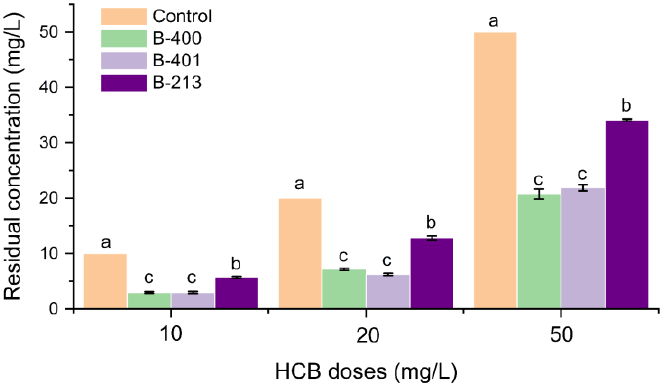
Figure 1. HCB destruction by C. testosteroni bacterial strains: UCM B-400, B-401, B-213. M ± the standard deviation (SD), a, b, c indicated in the graph means the values that significantly differ one from another within one column, which indicates growing activity of studied strains as a result of comparison using the Tukey’s test ( p < 0.05).